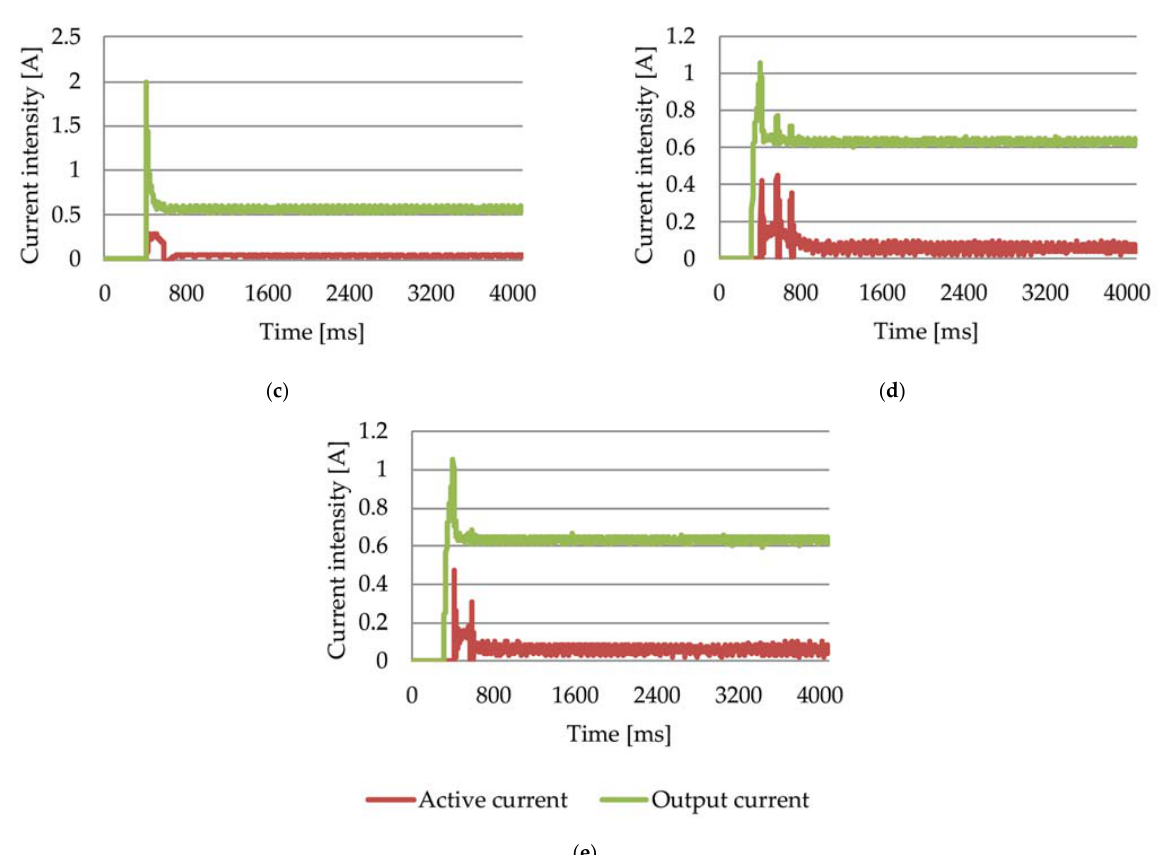
Figure 2. Characteristics of the output current intensity (I O ) and the active current intensity (I A ) in various control modes (without an external load): ( a ) V/f, ( b ) VFC without encoder, ( c ) VFC n-control, ( d ) CFC, ( e ) CFC with torque control.